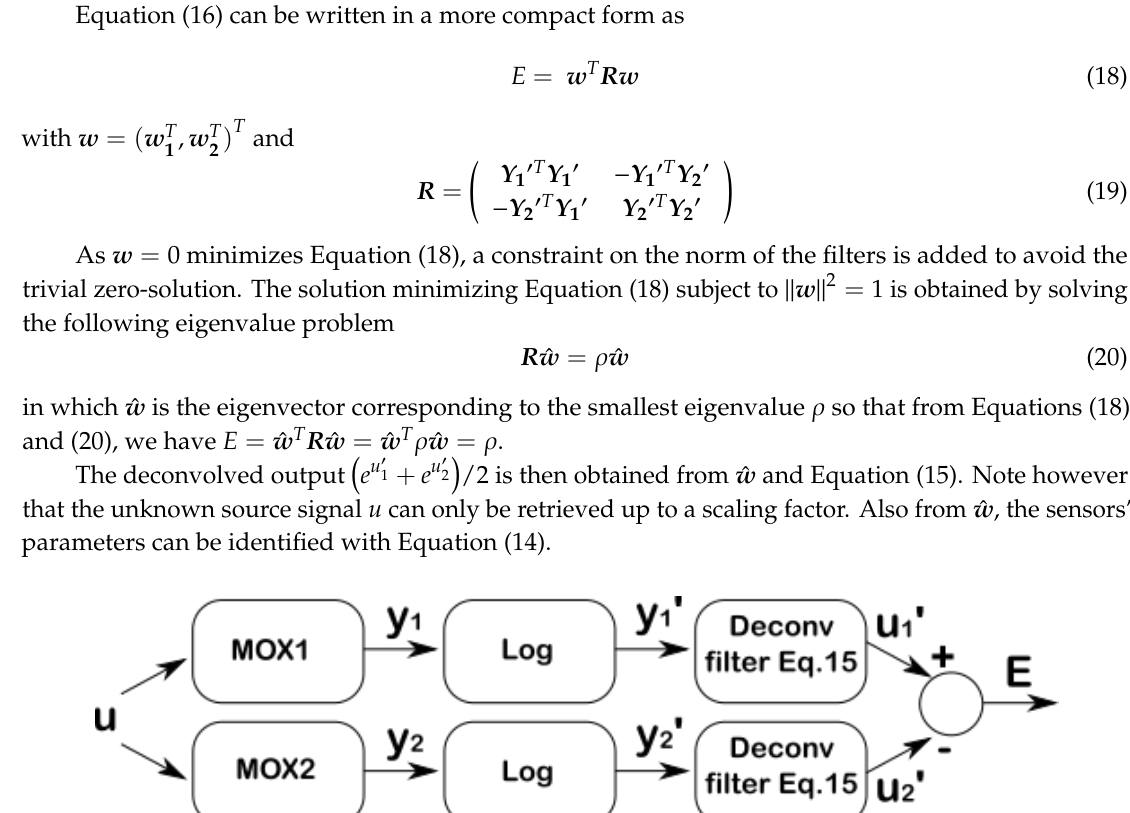
and u (cid:48) should be 2 1